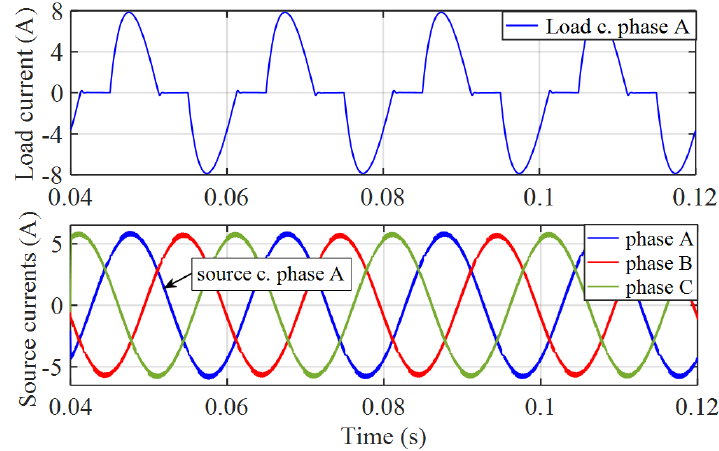
Figure 6. Load and source currents in HC practical simulation. The load ITHD is 43%. The source ITHD becomes 2.4%.